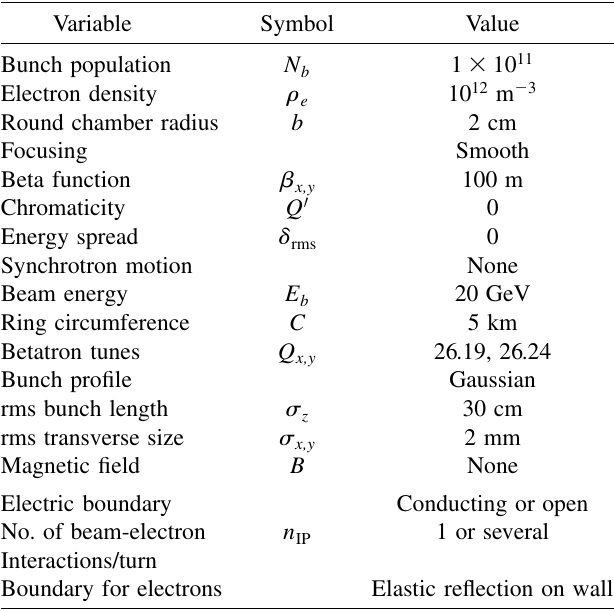
TABLE I. Parameters for benchmarking of instability simula- tion codes.